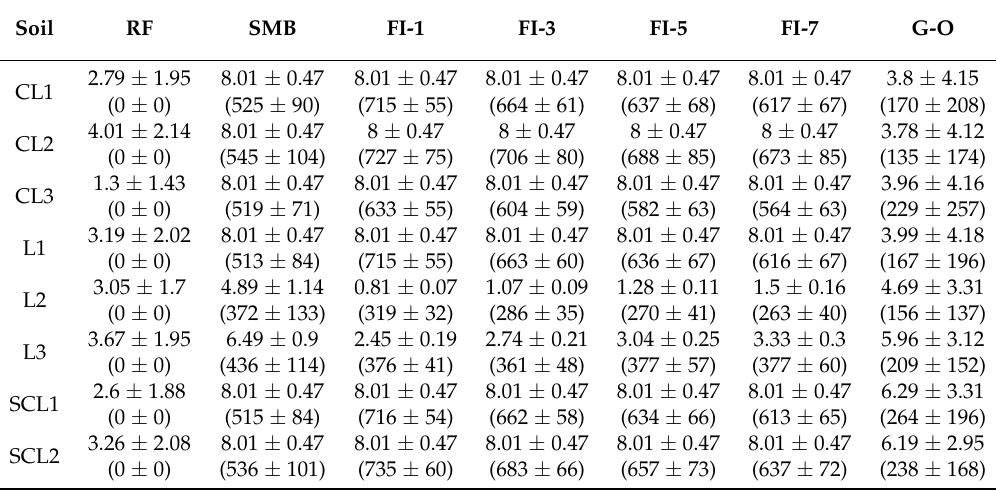
Table A3. Dry yield (in t ha − 1 ) and water use (in mm) for wheat, as a function of soil type according to irrigation strategy, as a mean value of simulated values from 1965 to 2016. Values outside and inside parentheses indicate dry yield and water use,